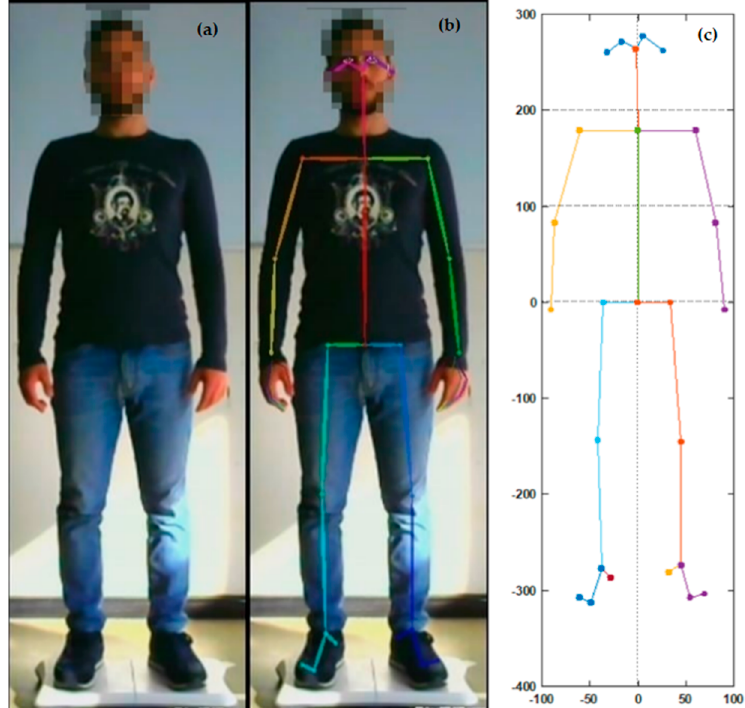
Figure 3. ( a ) Original frame; ( b ) postprocessed frame by OpenPose; ( c ) plot of the key